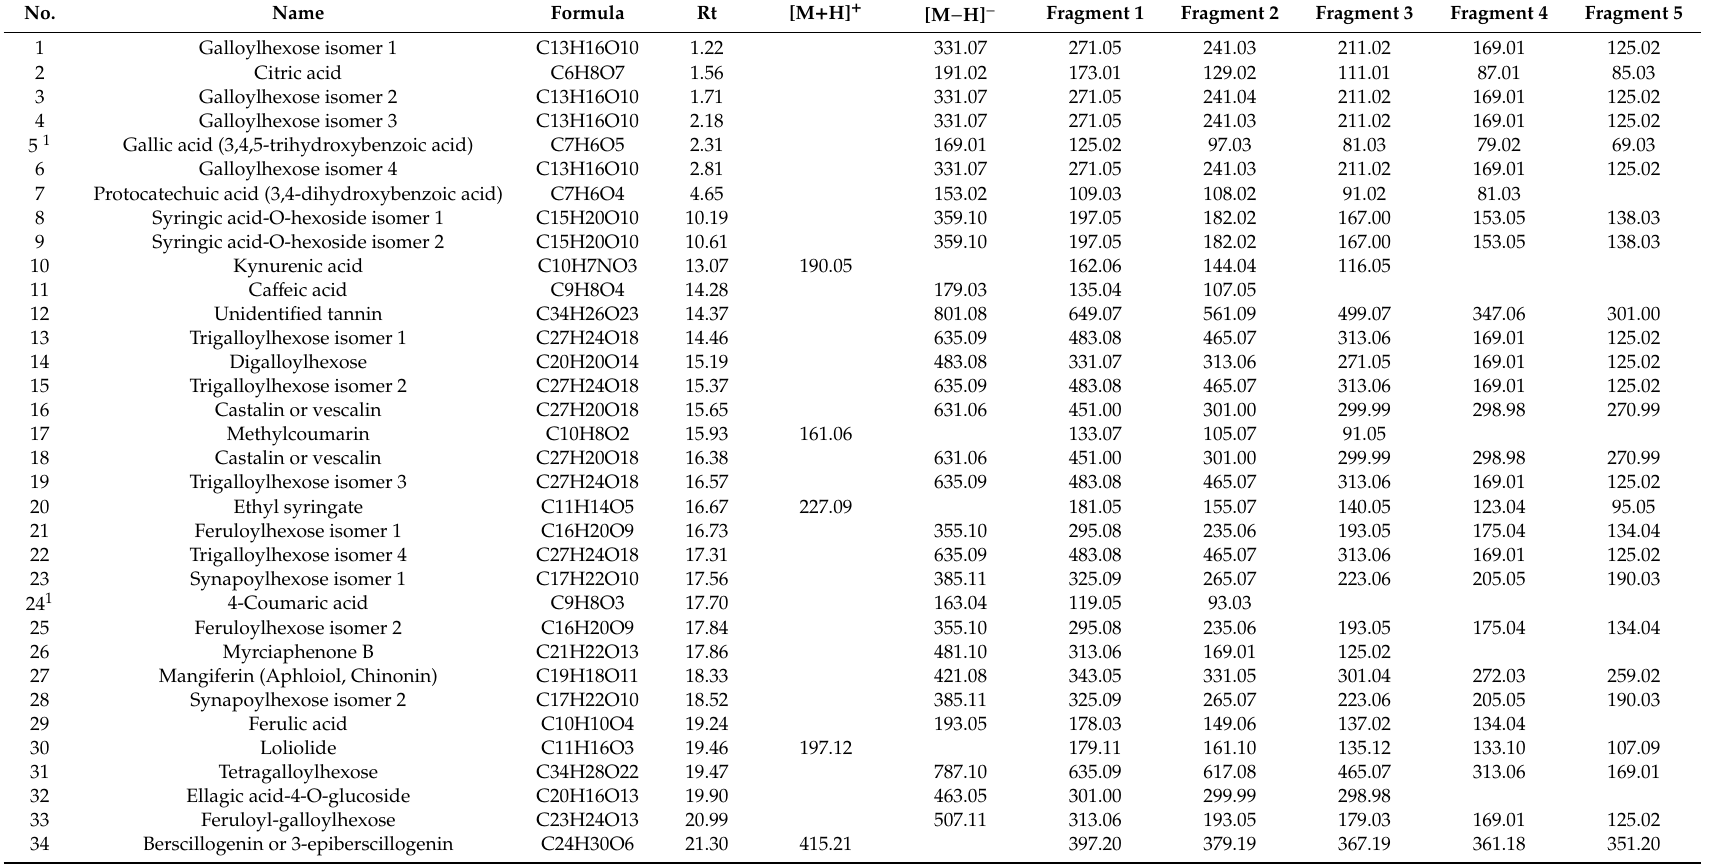
Table 5. Chemical composition of methanol